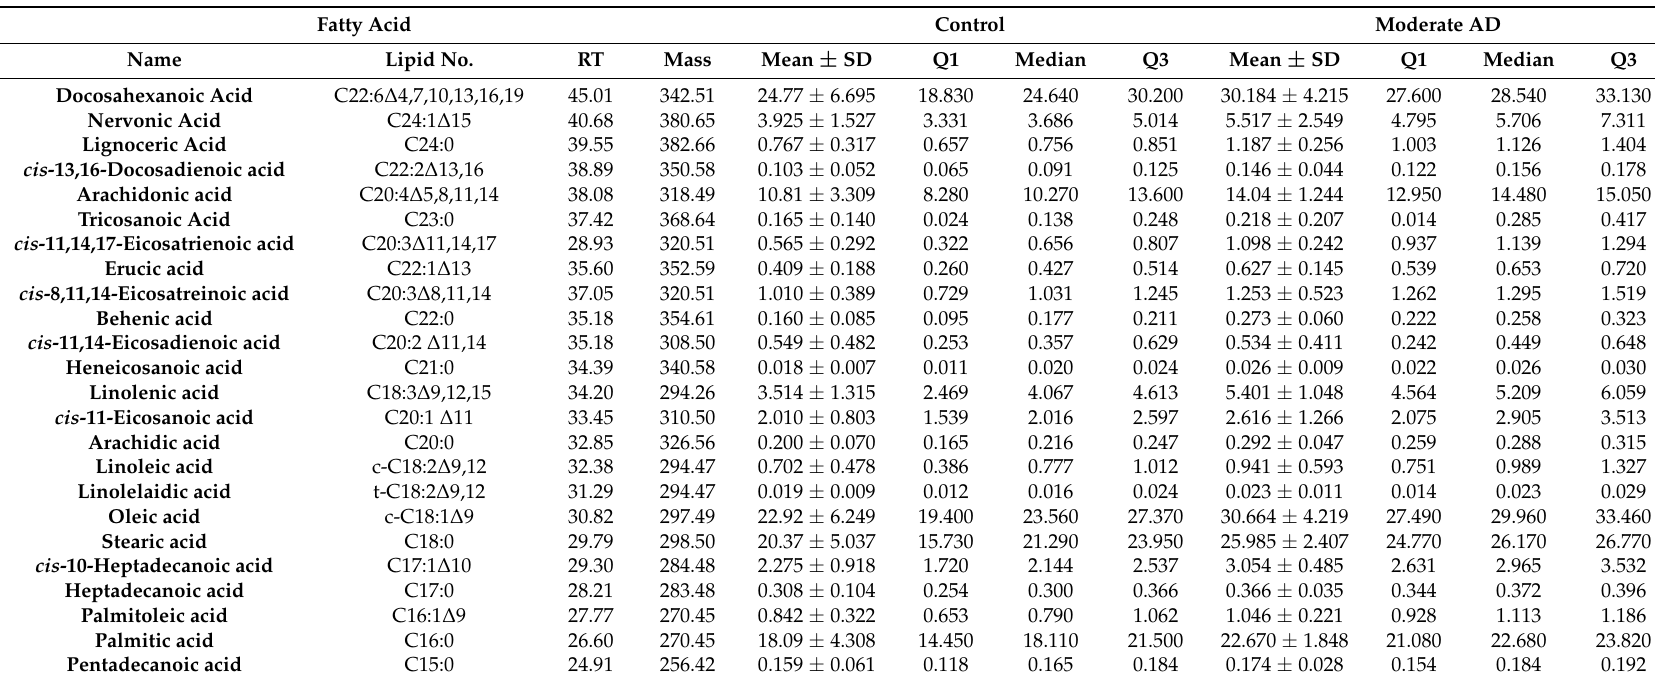
Table 1. Fatty acid measurements in post-mortem brain samples of Brodmann 7 region from control, moderate stage AD, full/late stage AD, and DLB subjects. FA concentrations (g/kg dry weight) displayed as mean ± standard deviation (SD), 1st Quartile (Q1), median, and 3rd Quartile (Q3). The adjusted false discovery rate (FDR) value of p < 0.05 generated from the Kruskal–Wallis (KW) tests was deemed to be significant. Total FA was calculated based on all 24 measured